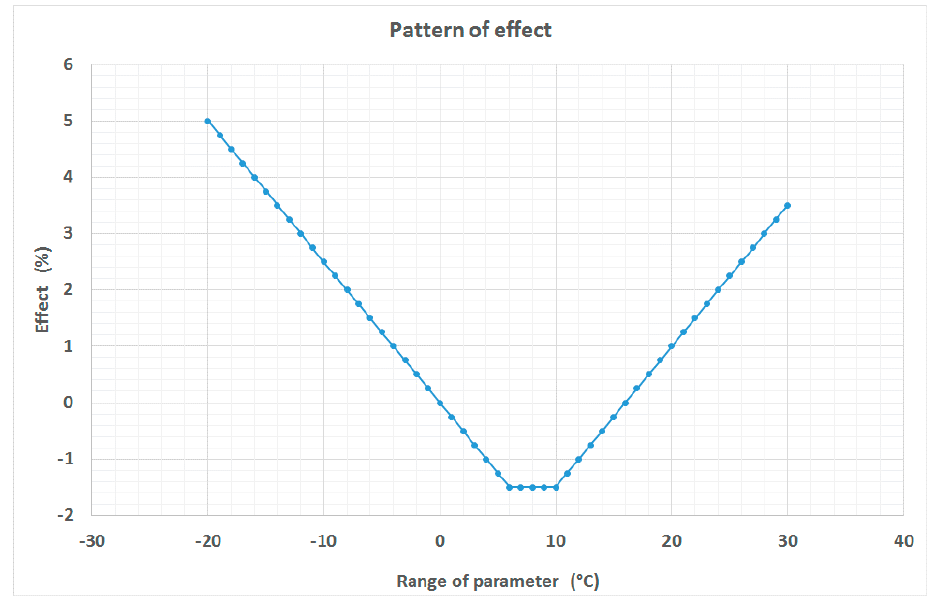
Figure 2. Range of exposure of cold and warm conditions in positive and negative conditions of thermal component (illustration depicts only the effect range on negative (>0) and positive (<0)).